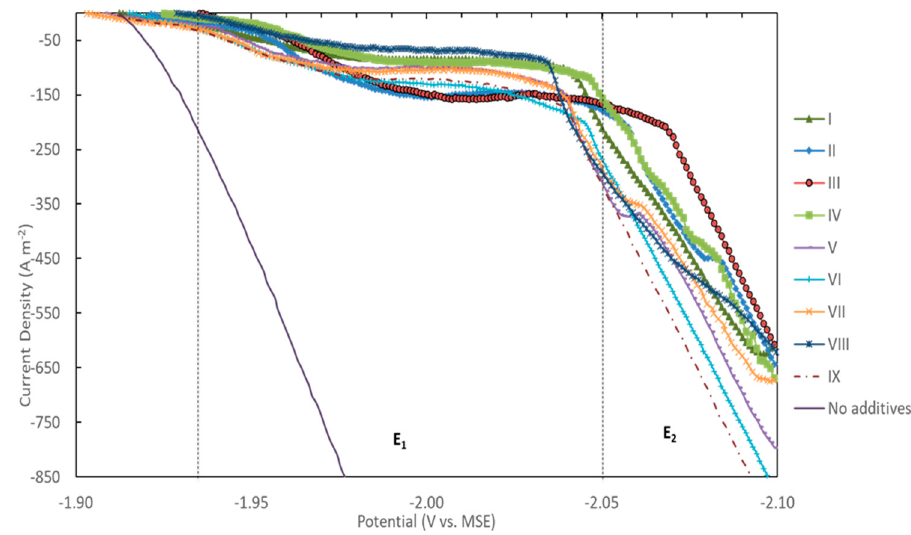
Figure 5. Cathodic polarization of plating baths with 37.5 g L − 1 zinc and 210 g L − 1 NaOH at 40 °C produced at a sweep rate of 1 mV s − 1 . Bath additive concentrations are provided in Table 1.